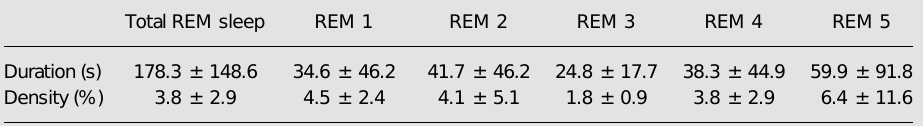
Table 1. Sawtooth wave duration and density observed in 10 volunteers during the basal night.